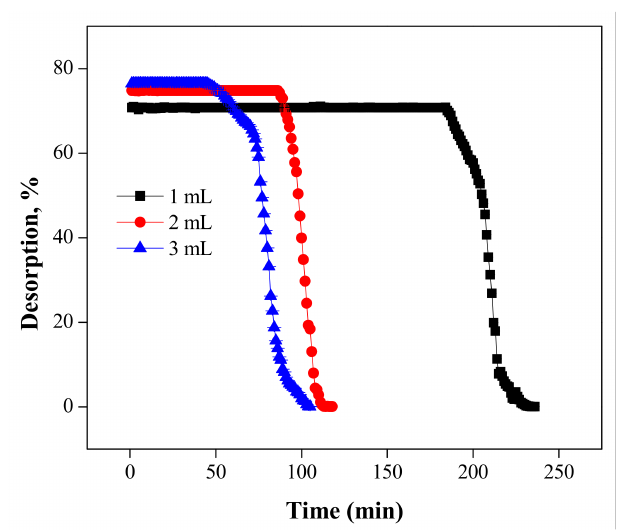
Figure 13. Desorption of Cr(VI) at various flow rates using the 2 M NaOH